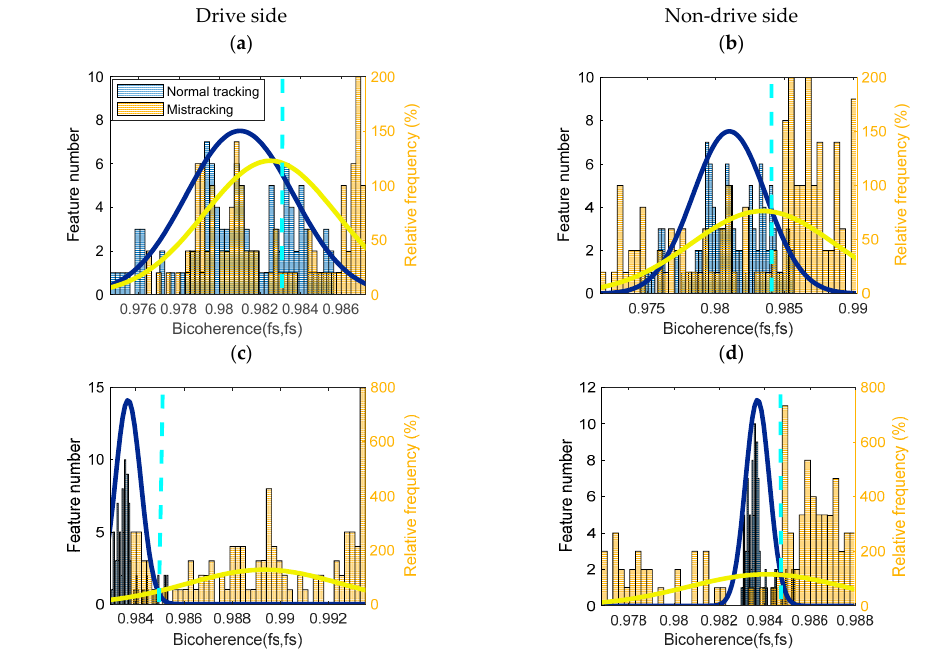
Figure 5. Histograms, probability density function and diagnostic thresholds represented as the aqua dotted line for the bicoherence (fs, fs) for normal and belt mis-tracking conditions: ( a ) Drive side belt mis-tracking under no-load condition, ( b ) Non-drive side belt mis-tracking under no-load condition, ( c ) Drive side belt mis-tracking under 20 kg load condition, ( d ) Non-drive side belt mis-tracking under 20 kg load condition.